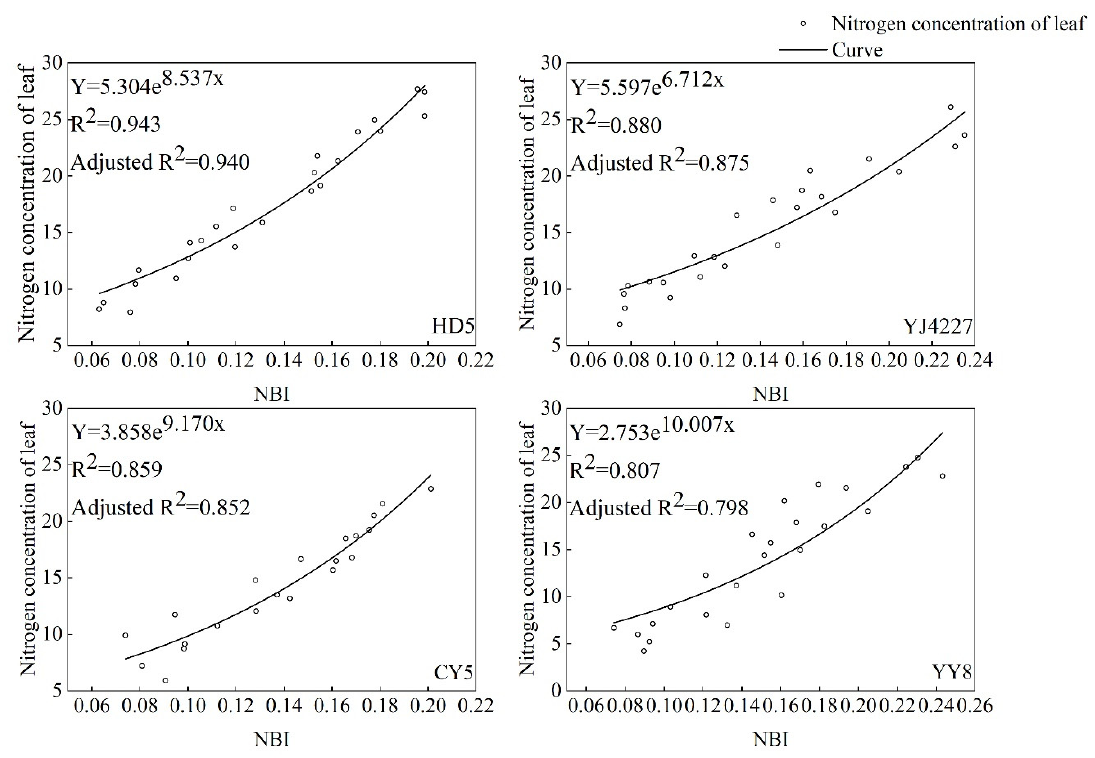
Figure 11. Curves for the nitrogen content vs. NBI of rice leaves after anthesis.